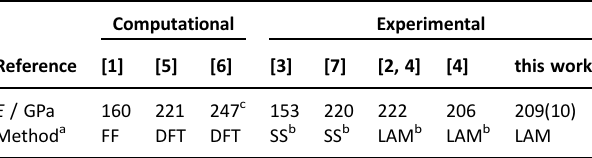
a FF = force field calculation, DFT = density functional theory calcula- tion, SS = stress-strain measurement, LAM = LAM frequency extra- polation; b solid state; c planar